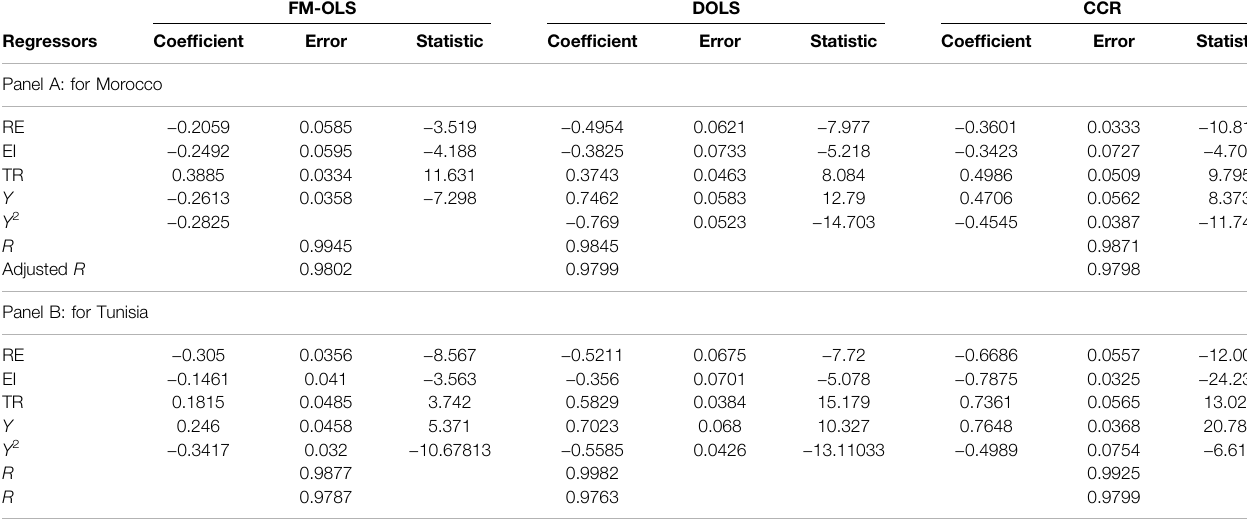
TABLE 11 | Results of the empirical model robustness